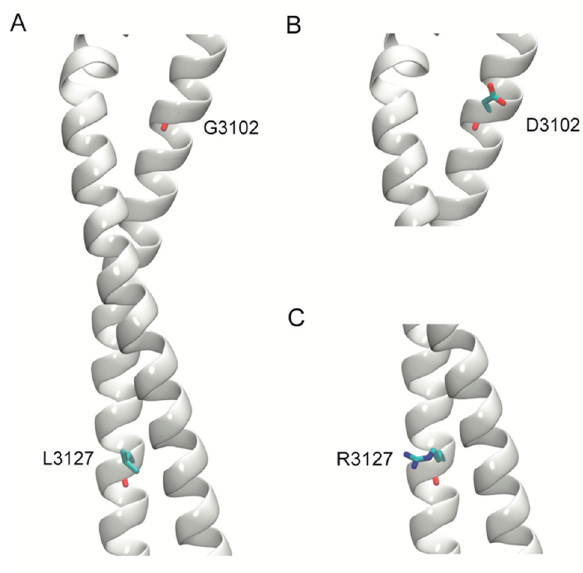
Figure 4. Models of the stalk region of the wild-type (WT) and variant structures of DNAH11. The stalk region of the protein is represented as a white helix and amino acids are shown in stick representation. ( A ) WT structure with G3102 and L3127. ( B ) Structure of the variant G3102D. ( C ) Structure of the variant L3127R.